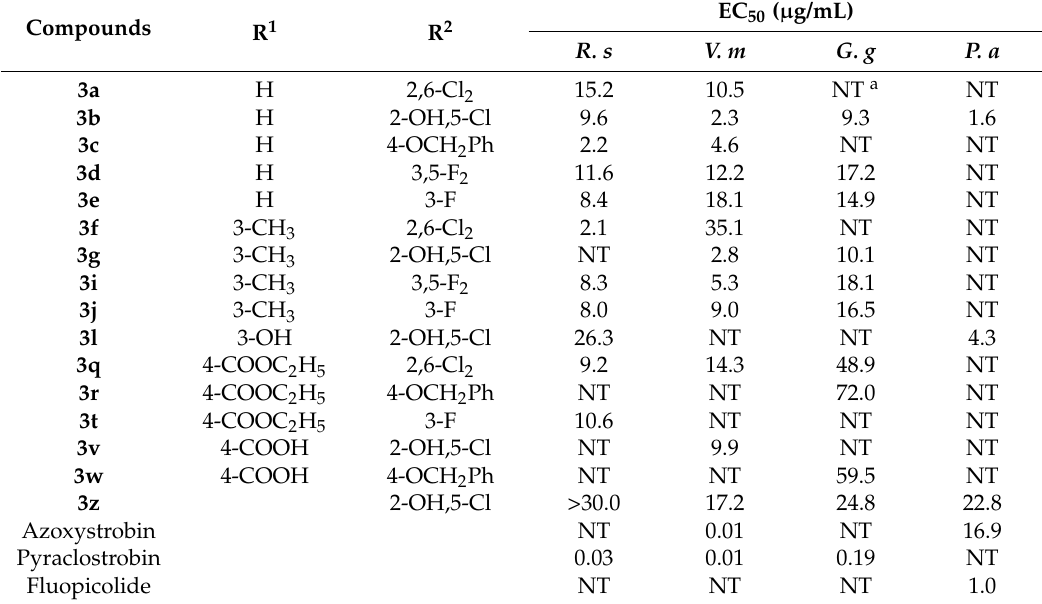
Table 2. The EC 50 value of some title compounds.